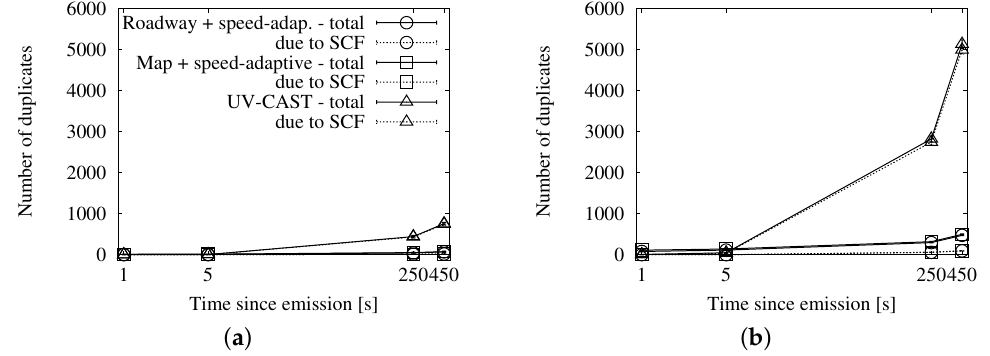
Figure 17. Sent duplicates in comparison with UV-CAST in the New York scenario: ( a ) 25 vehicles/km 2 ; ( b ) 100 vehicles/km 2